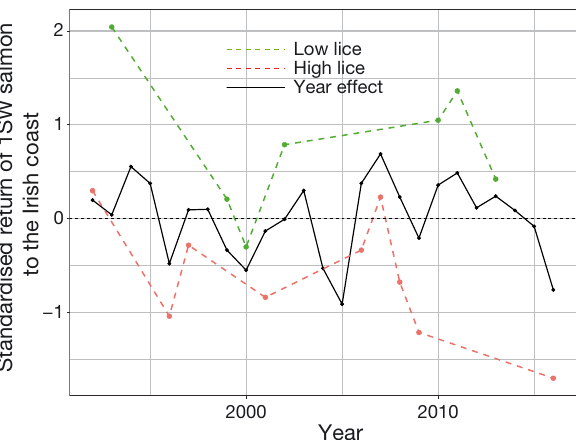
Fig. 8. Observed Erriff River Atlantic salmon returns to the river ( S iRiver ), standardised to 0 for years estimated to have ‘High’ and ‘Low’ levels of sea lice (years of Medium lice level are excluded for clarity). Year effect is the random effect of year ( Ycat i ), assumed to express environmental effects on salmon